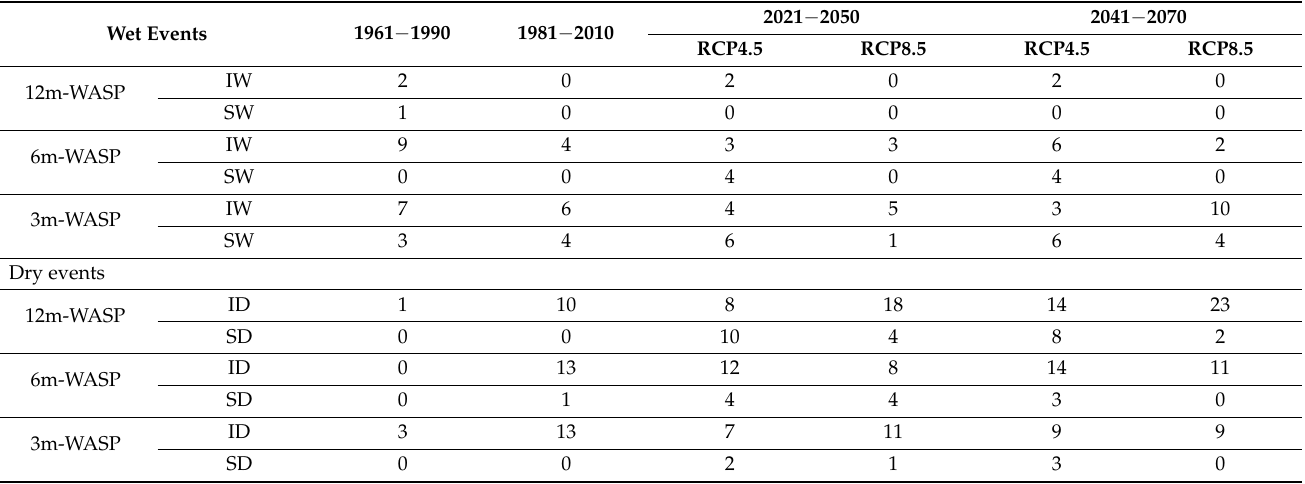
Table 3. Number of intermediate-to-severe wet and dry events for the past periods 1961 − 1990, 1981 − 2010, and for the future periods 2021 − 2050 and 2041 − 2070 under RCP4.5 and RCP8.5 1